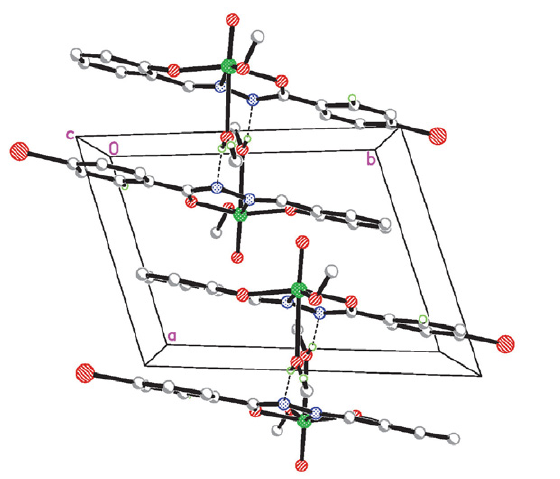
Figure 4. The molecular packing diagram of the complex, viewed down the c axis. Hydrogen bonds are shown as dashed lines.